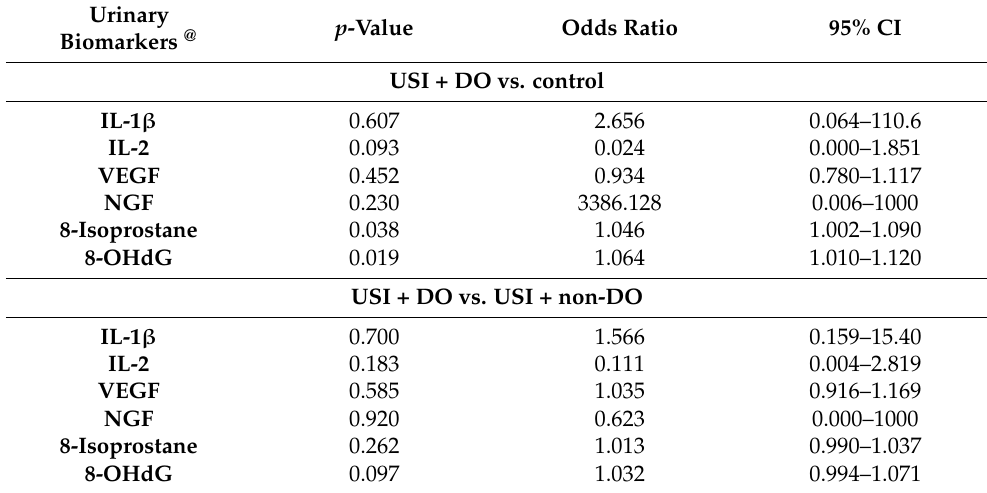
Table 5. Multivariate analysis of the targeted urinary biomarkers (adjusting for age, DM, and history of CVA and anti-incontinence